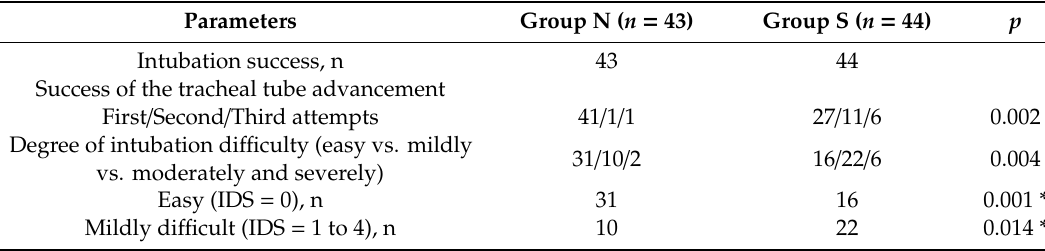
Table 2. Intubation